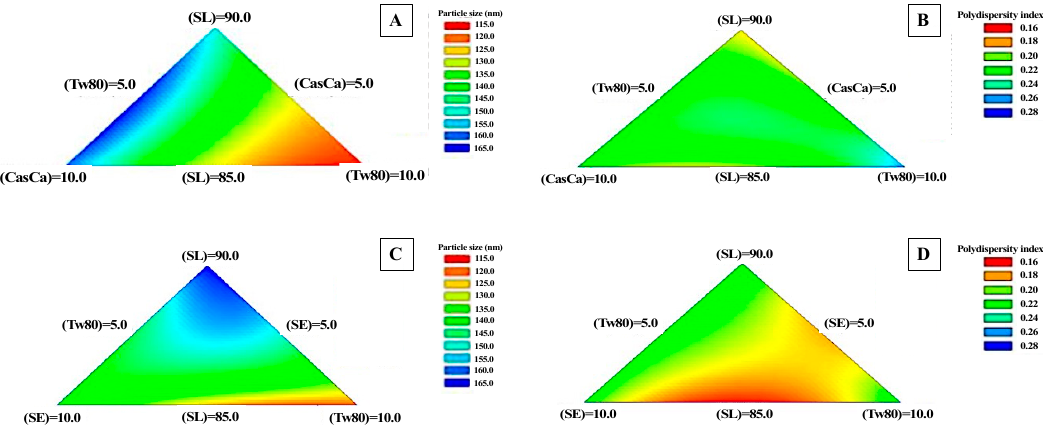
M 1 : mixture 1 (soy lecithin-SL, Tween 80-Tw80 and sodium caseinate-CasCa), and M 2 : mixture 2 (soy lecithin—SL, Tween 80—Tw80 and sucrose ester—SE). Di ff erent letters indicate significant di ff erences ( p < 0.05) in the same parameter (column) in each emulsifier mixture.